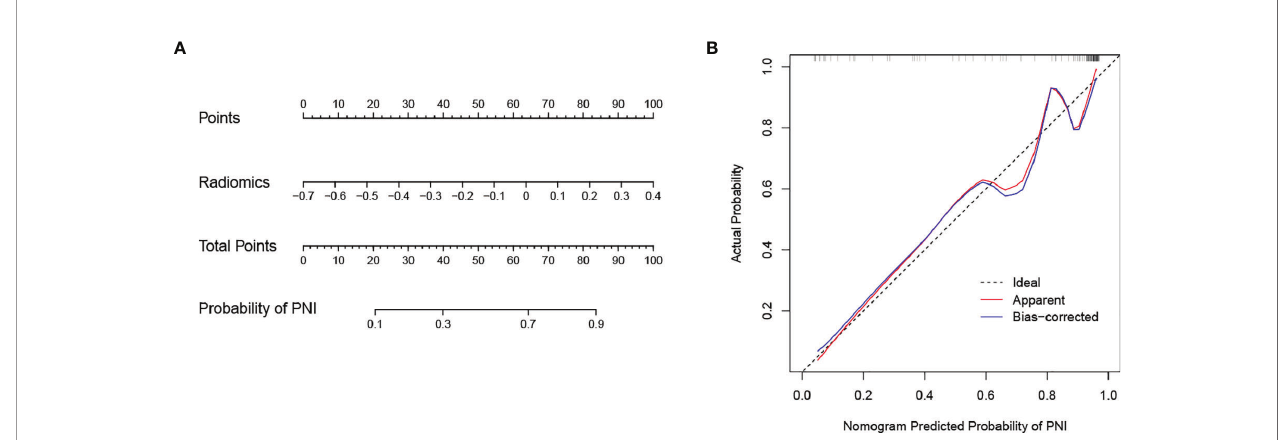
FIGURE 5 | Nomogram developed with the radiomics model and calibration curves of the nomogram. (A) The developed radiomics nomogram to predict PNI in patients with pCCA. (B) Calibration curves of the nomogram. The x-axis and the y-axis show the nomogram predicted probabilities of PNI and the actual probabilities, respectively. The diagonal gray line presents a perfect prediction, and the red solid line presents the predictive performance of the nomogram. Better prediction is indicated by a closer fi t of the red solid line to the diagonal gray